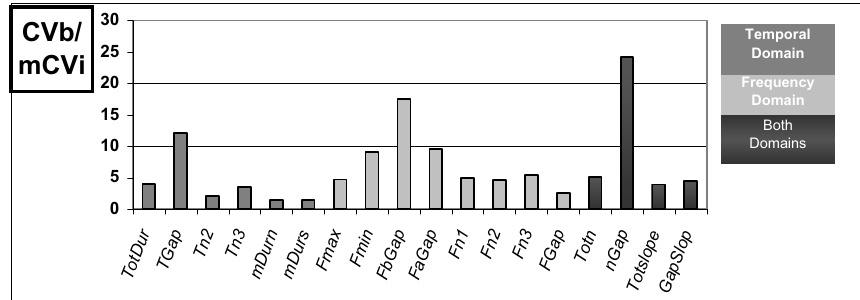
Fig. 2 – Results corresponding to the ratio between the inter-individual coefficient of variation (CV b ) and the mean intra-individual coefficient of variation (mean CV i ) calculated for 18 acoustic parameters of the song. Higher values correspond to parameters linked to the main gap: Tgap, FaGap,